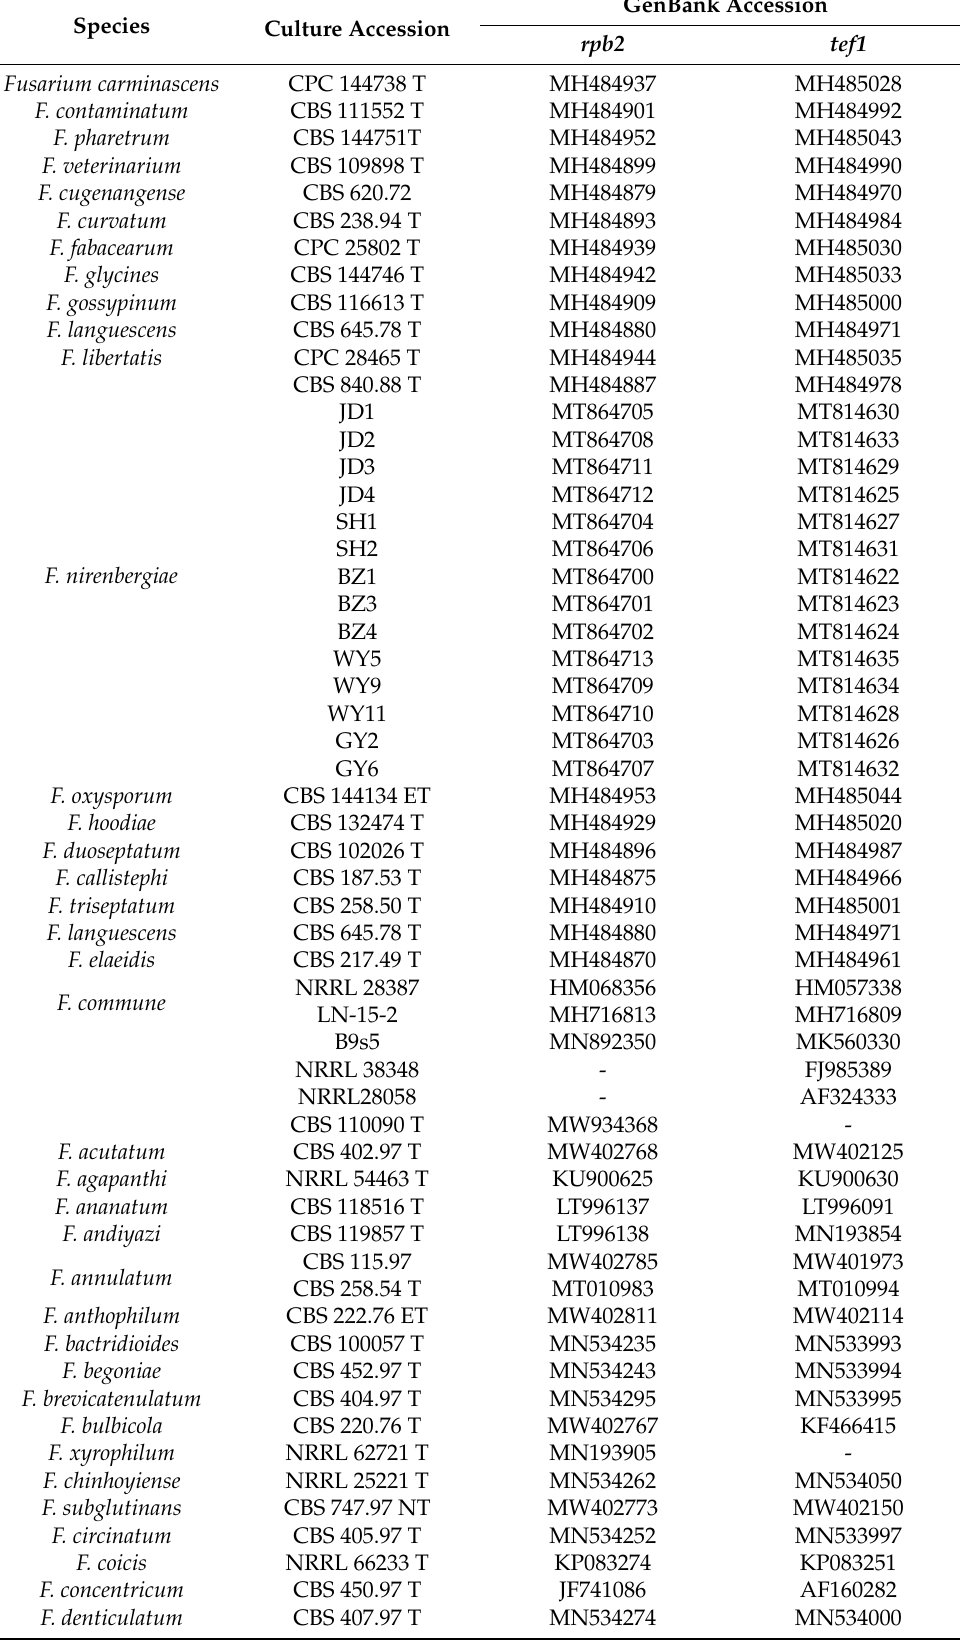
Table 3. Fusarium strains used in this